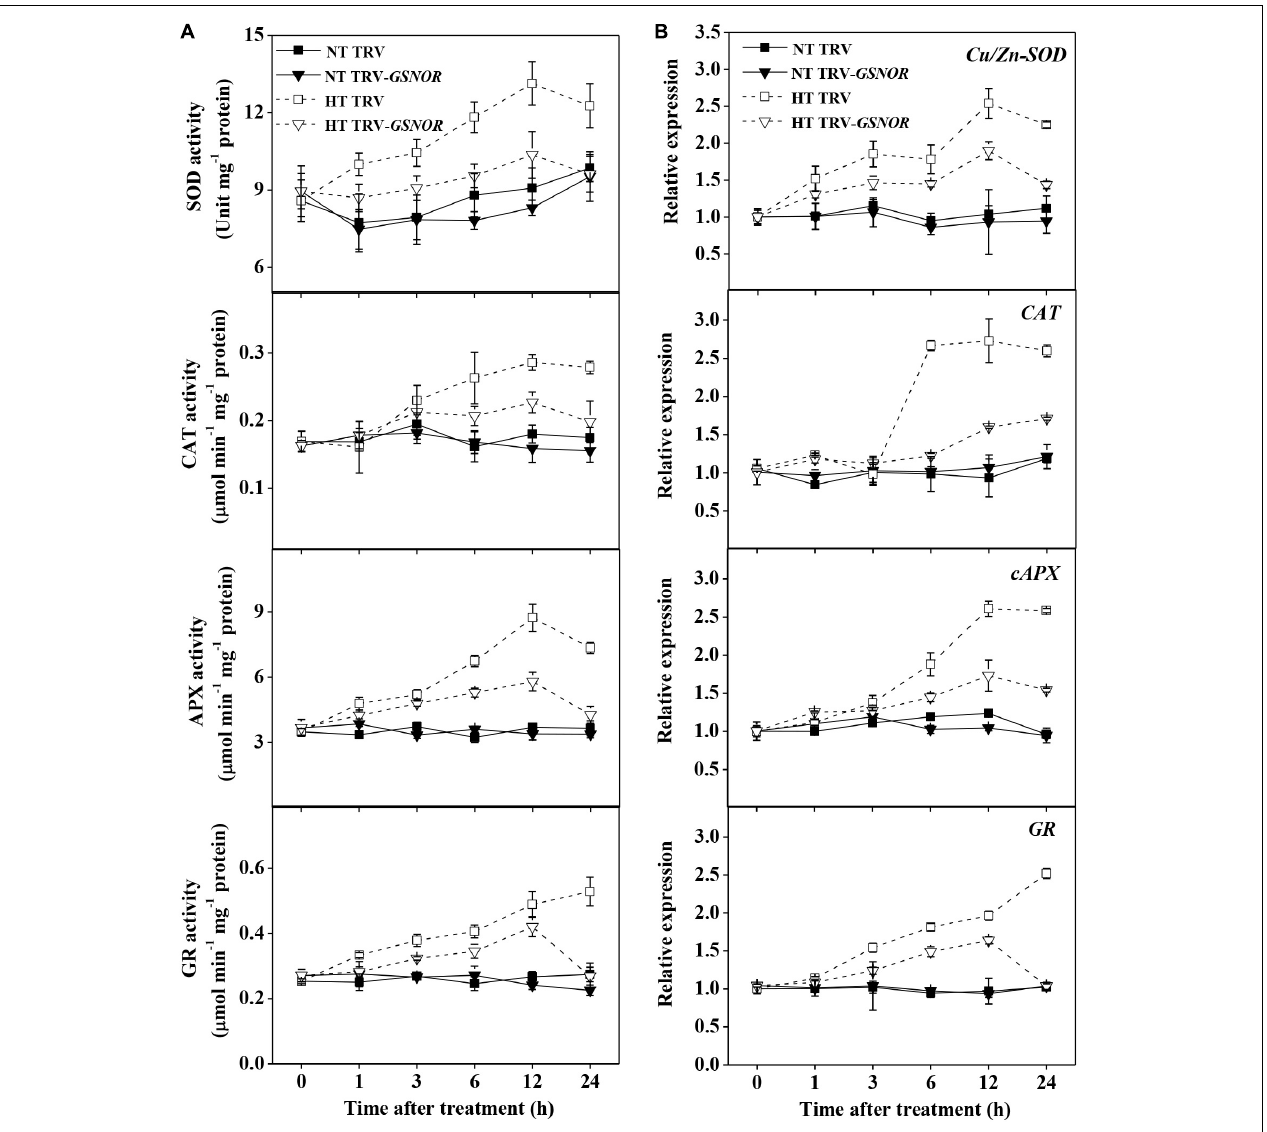
FIGURE 5 | Silencing of SlGSNOR1 compromised upregulation of antioxidant capacity in response to high temperature. (A) Changes in the activity of antioxidant enzymes, superoxide dismutase (SOD), catalase (CAT), ascorbate peroxidase (APX), and glutathione reductase (GR). (B) Changes in the relative transcript levels of antioxidant genes, Cu/Zn-SOD , cAPX , CAT and GR . Data are means of three to five replicates ( ± SD). NT, normal temperature; HT, high